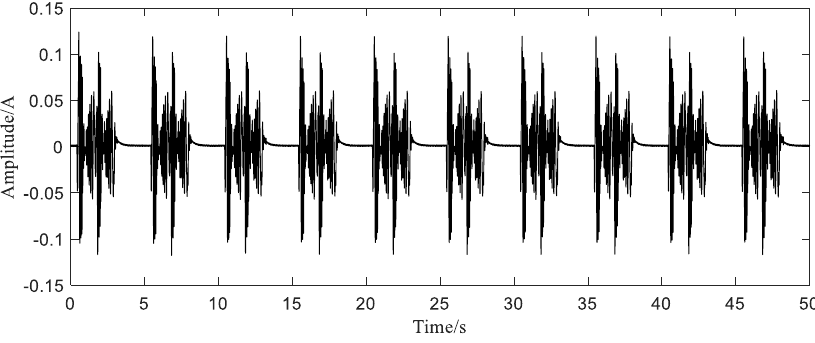
Sensors 2020 , 20 , x FOR PEER REVIEW